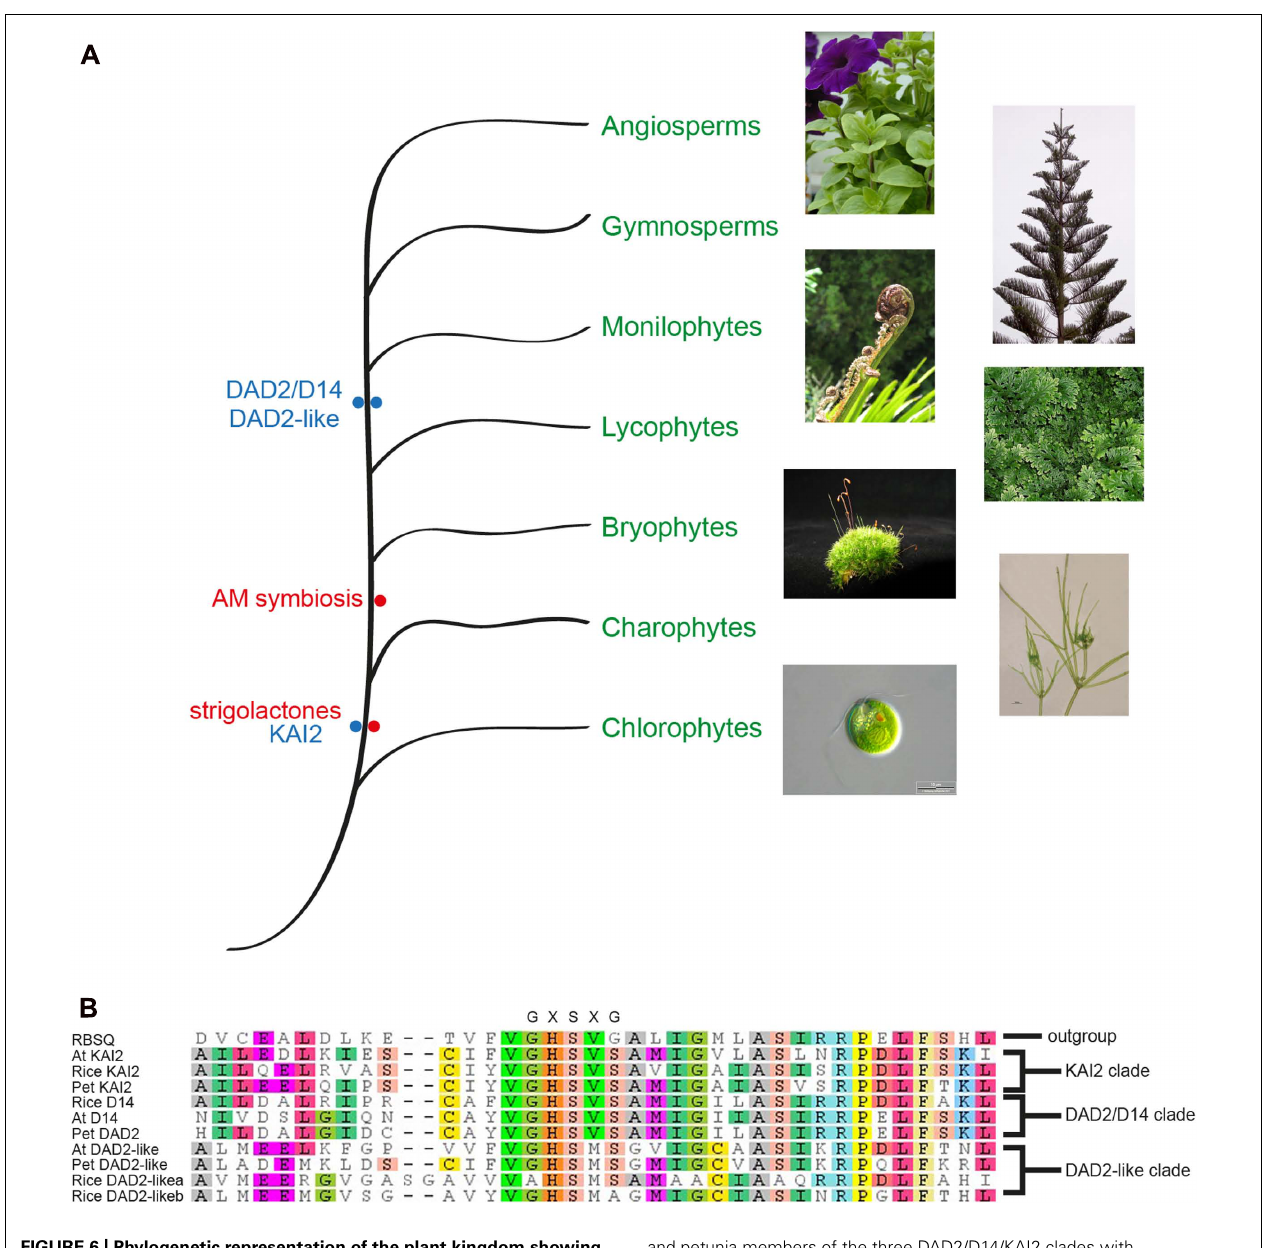
and petunia members of the three DAD2/D14/KAI2 clades with RBSQ as the outgroup (Drummond etal., 2010).The nucleophilic elbow GXSXG motif at the active site serine is shown above the alignment (B) . RSBQ, Acc. No. 16080463; At KAI2, Acc. No. 15235567; Rice KAI2, Acc. No. 115453689; Pet KAI2, ABHF_7407 (from ChromDB http://www.chromdb.org/index.html); Rice D14, 32980850; At D14 Acc. No. 18396732; Pet DAD2, ABHF_7401; At DAD2-like, 15230110; Pet DAD2-like, ABHF_7407; Rice DAD2-likea, 115465775; Rice DAD2-likeb,